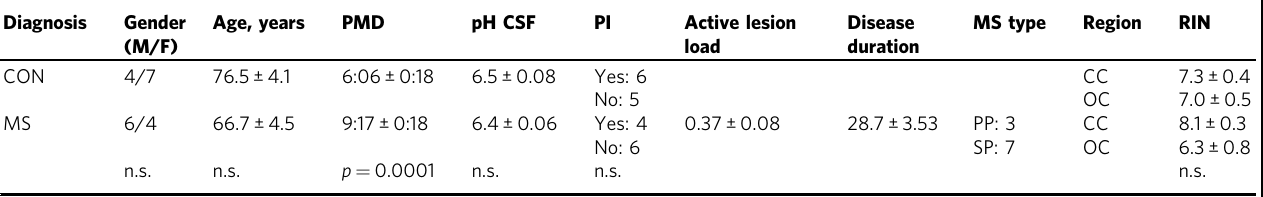
Table 1 Donor characteristics for MS and control donors used for RNA sequencing Diagnosis Gender